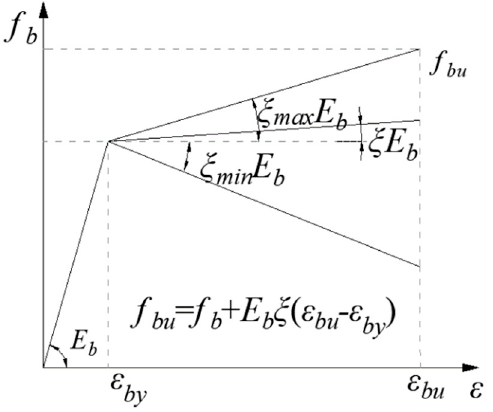
Figure 4. Stress–strain relationships for the CY block.